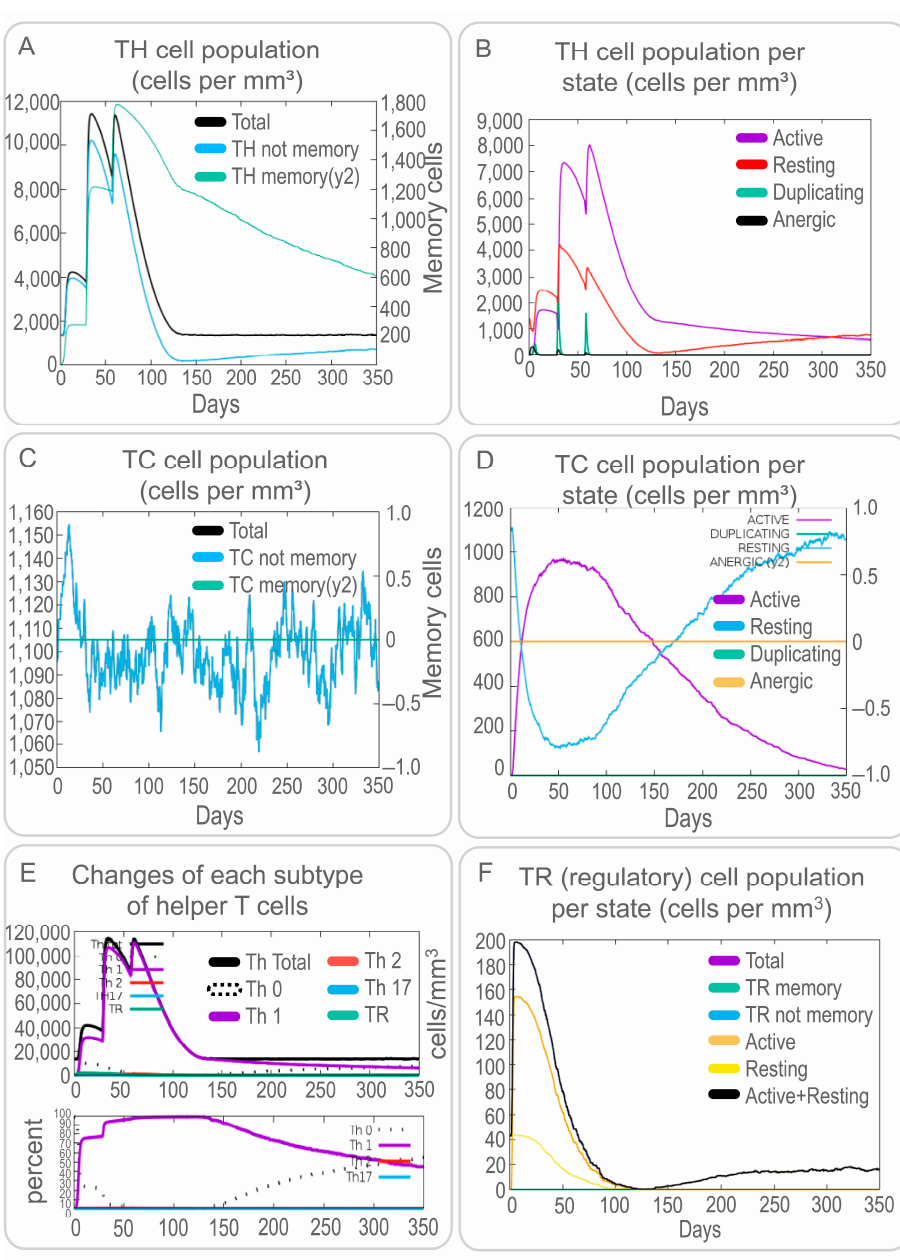
Figure 6. The PP19128R vaccine-induced changes in the populations of adaptive immune cells in silico. Simulated immunization with the PP19128R vaccine was performed three times by the C- immune server in silico, and the populations of helper T cells ( A , B ), cytotoxic T cells ( C , D ), subtypes of helper T cells ( E ), and regulatory T cells ( F ) were